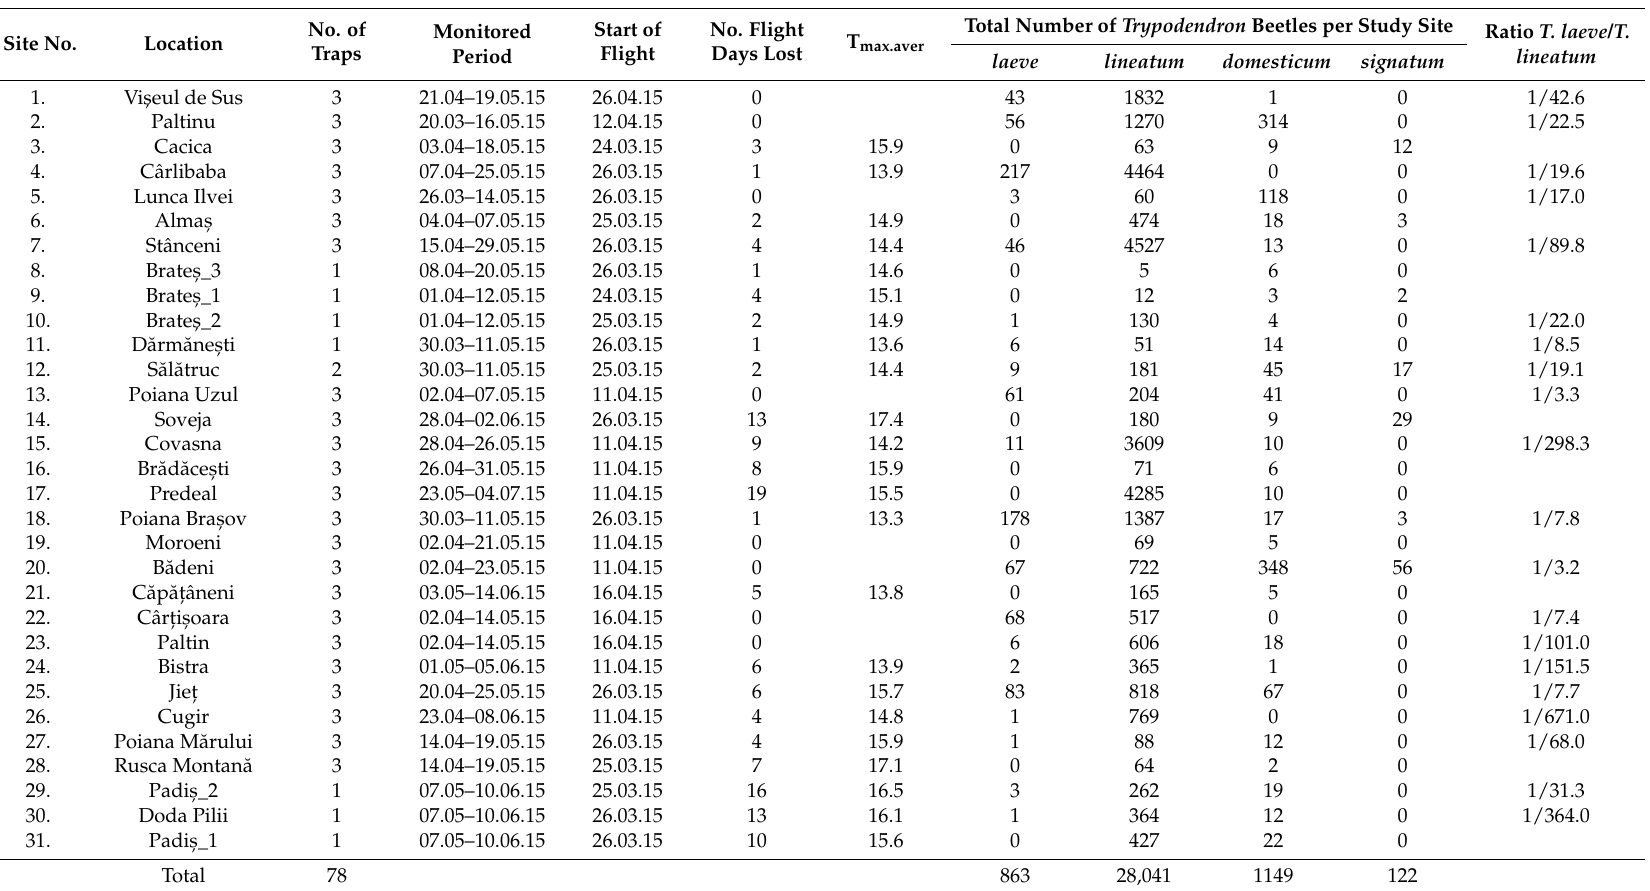
Table 2. Captures of Trypodendon species at the 31 sites monitored in